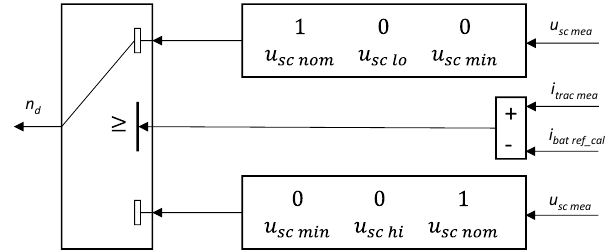
Figure 6. Limitation transition block.